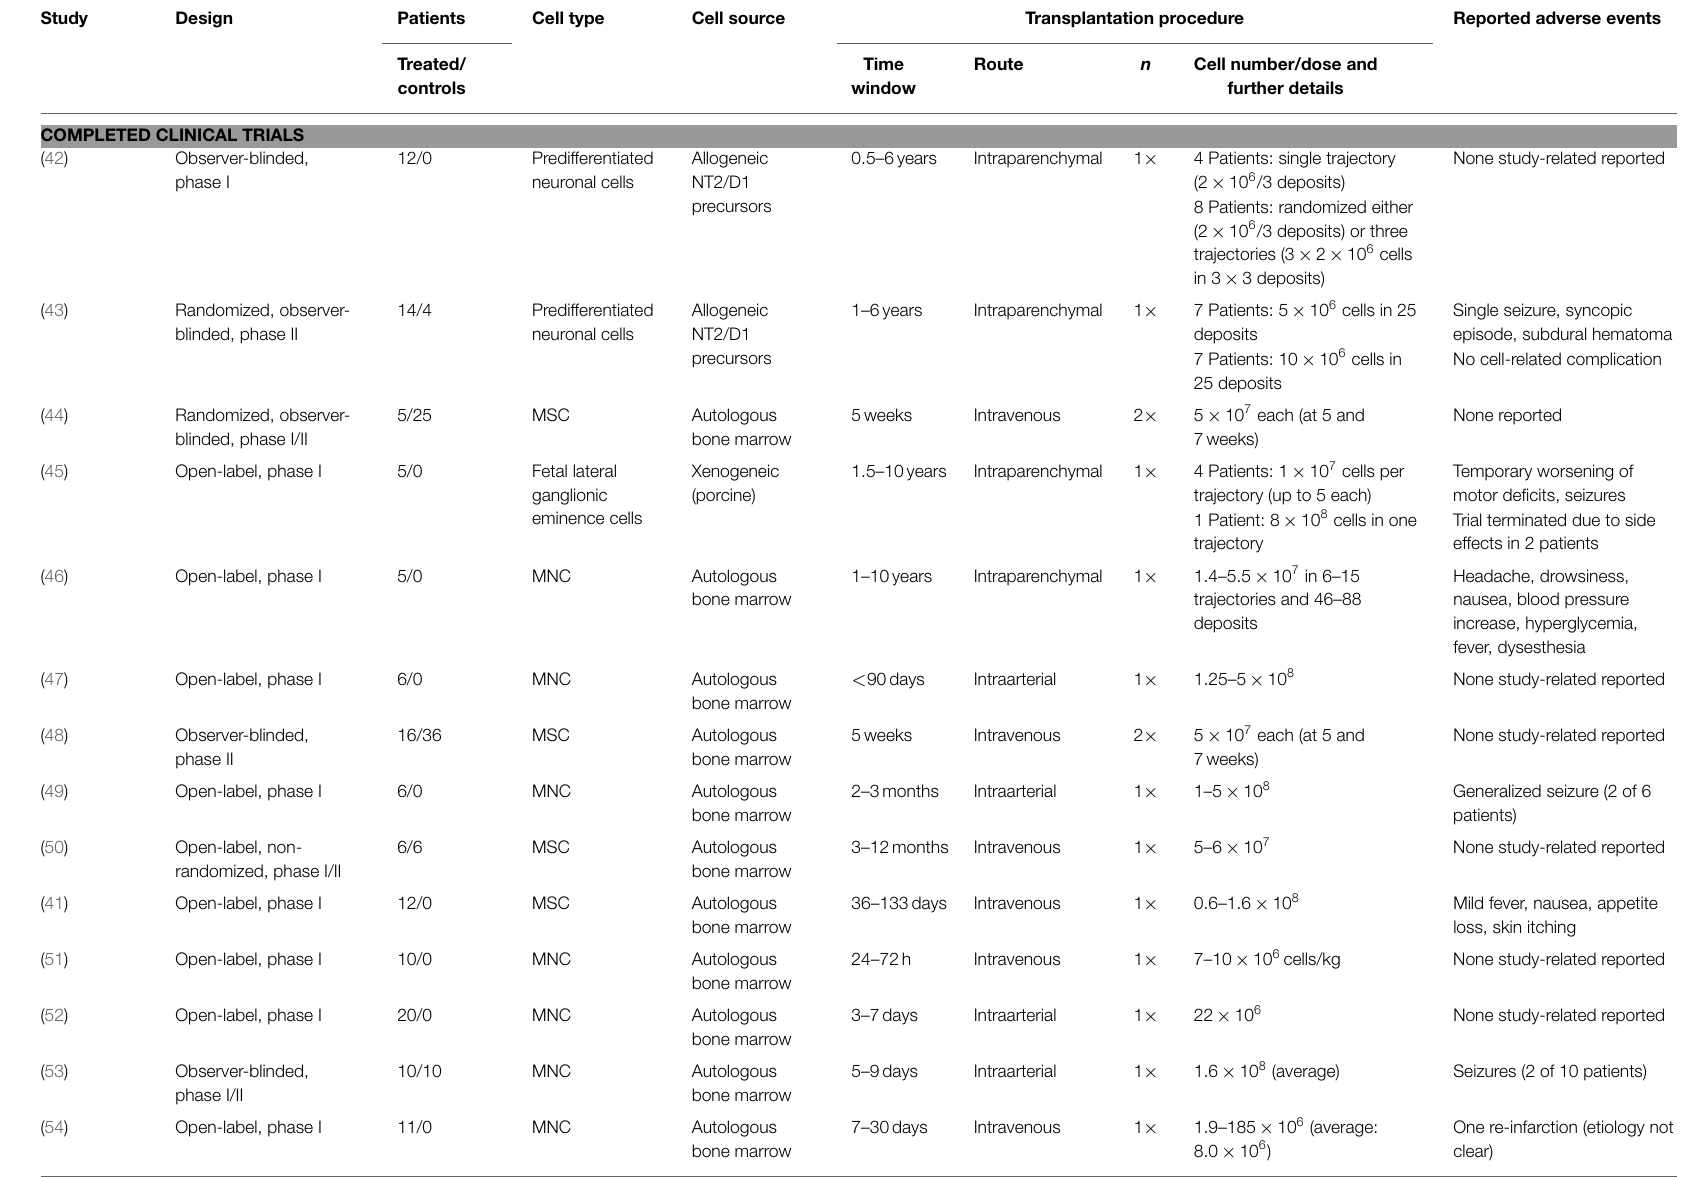
TABLE 2 | Current clinical trials investigating cell therapies for stroke including reported complications